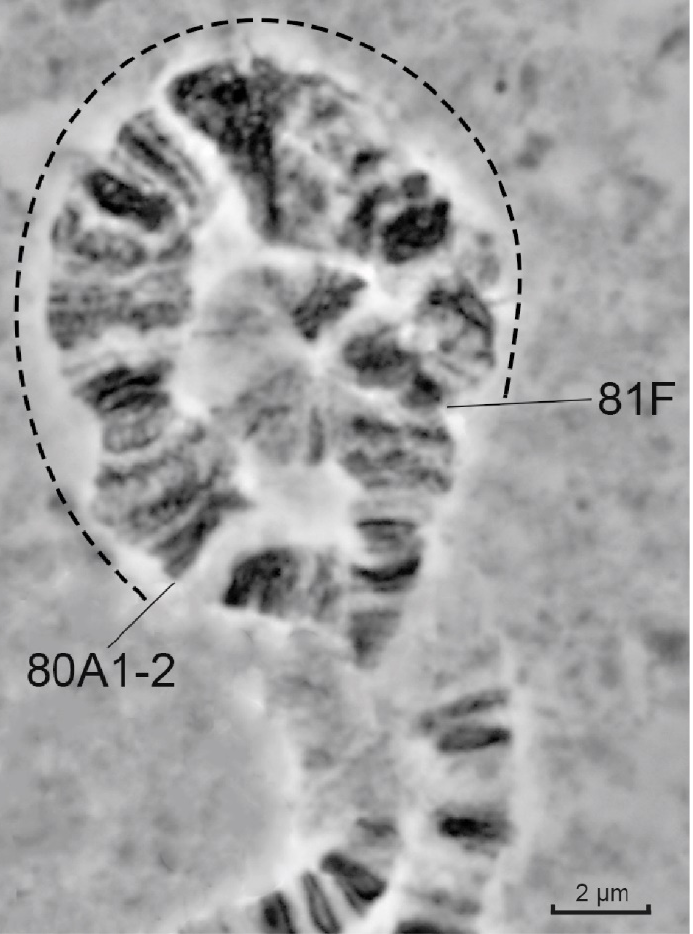
Figure 2. Morphology of pericentromeric heterochromatin of polytene chromosome 3 in the Rif1 1 ; SuUR ES Su(var)3-9 06 larvae. The dotted line between 80A1-2 and 81F delimits the newly polytenized pericentromeric heterochromatic region.